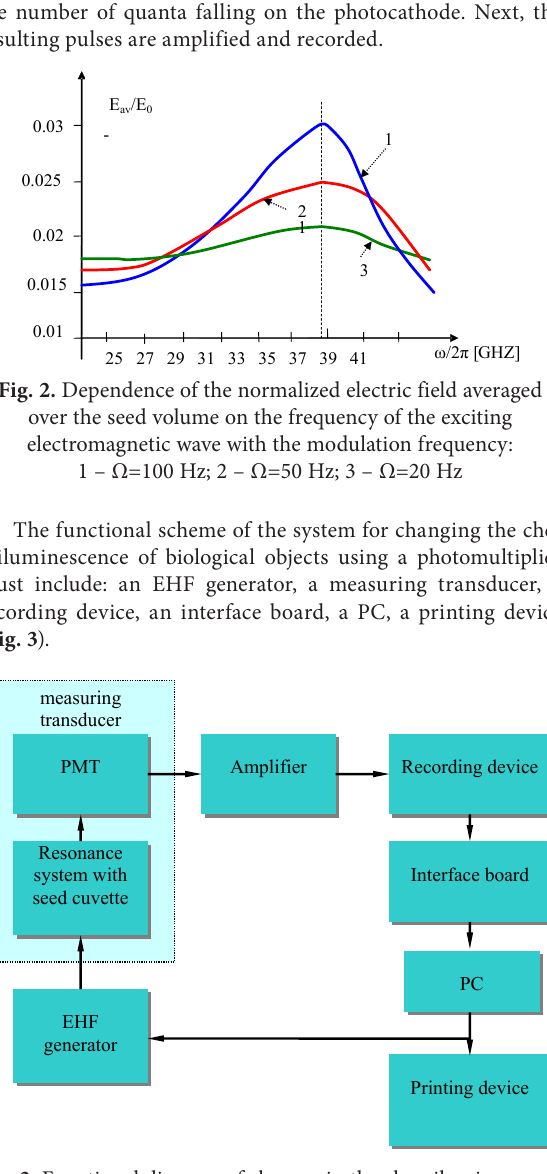
Fig. 3. Functional diagram of changes in the chemiluminescence of seeds